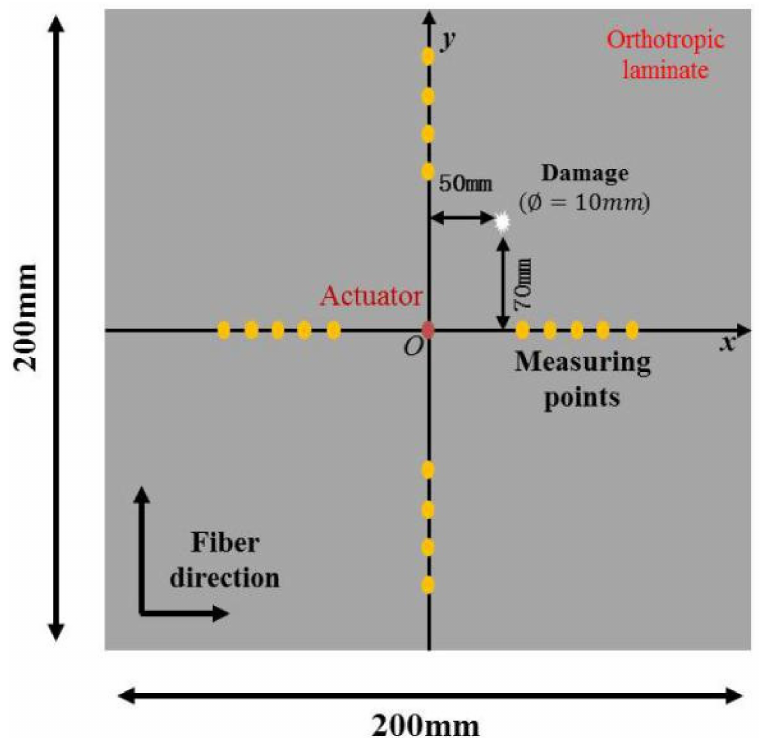
Figure 2. Schematic diagram of the composite laminate and sensor